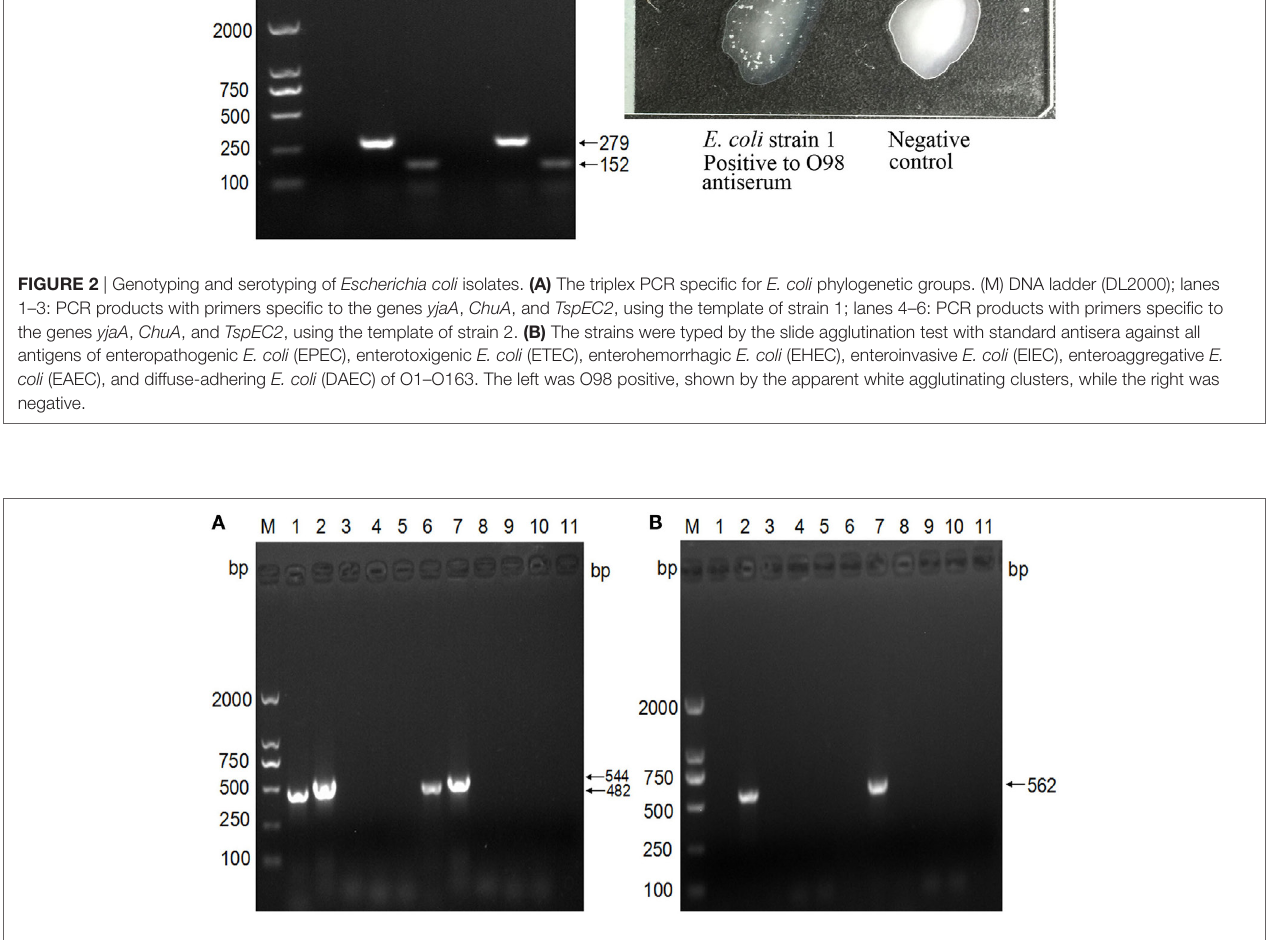
FigUre 3 | Subgenotyping of Escherichia coli isolates based on the virulence genes. (a) PCR analyses of virulence factors. M: DNA ladder (DL2000); lanes 1–5: PCR products with primers specific to the genes eae , escV , bfpB , stx1 , and stx2 , using the template of strain 1; lanes 6–10: PCR products with primers specific to the genes eae , escV , bfpB , stx1 , and stx2 , using the template of strain 2; lane 11: negative. (B) PCR analysis of intimin subtypes. M: DNA ladder (DL2000); lanes 1–5: PCR products with primers specific to intimin α , intimin β , intimin γ , intimin δ , and intimin ε , using the template of strain 1; lanes 6–10: PCR products with primers specific to intimin α , intimin β , intimin γ , intimin δ , and intimin ε , using the template of strain 2; lane 11: negative control.